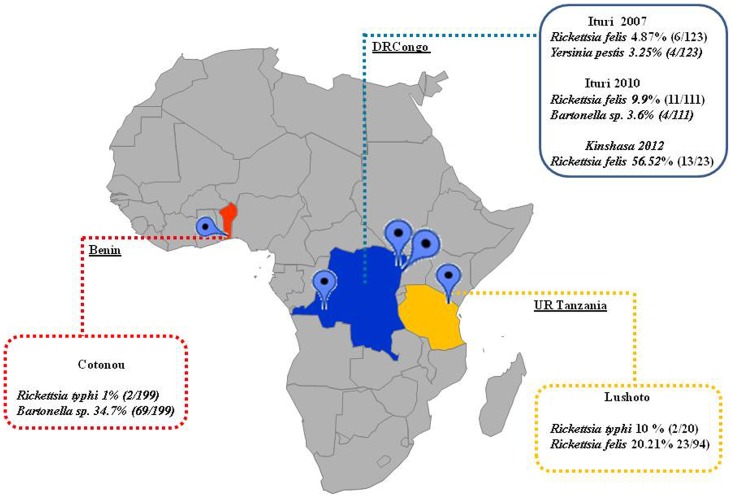
Sites of the study.